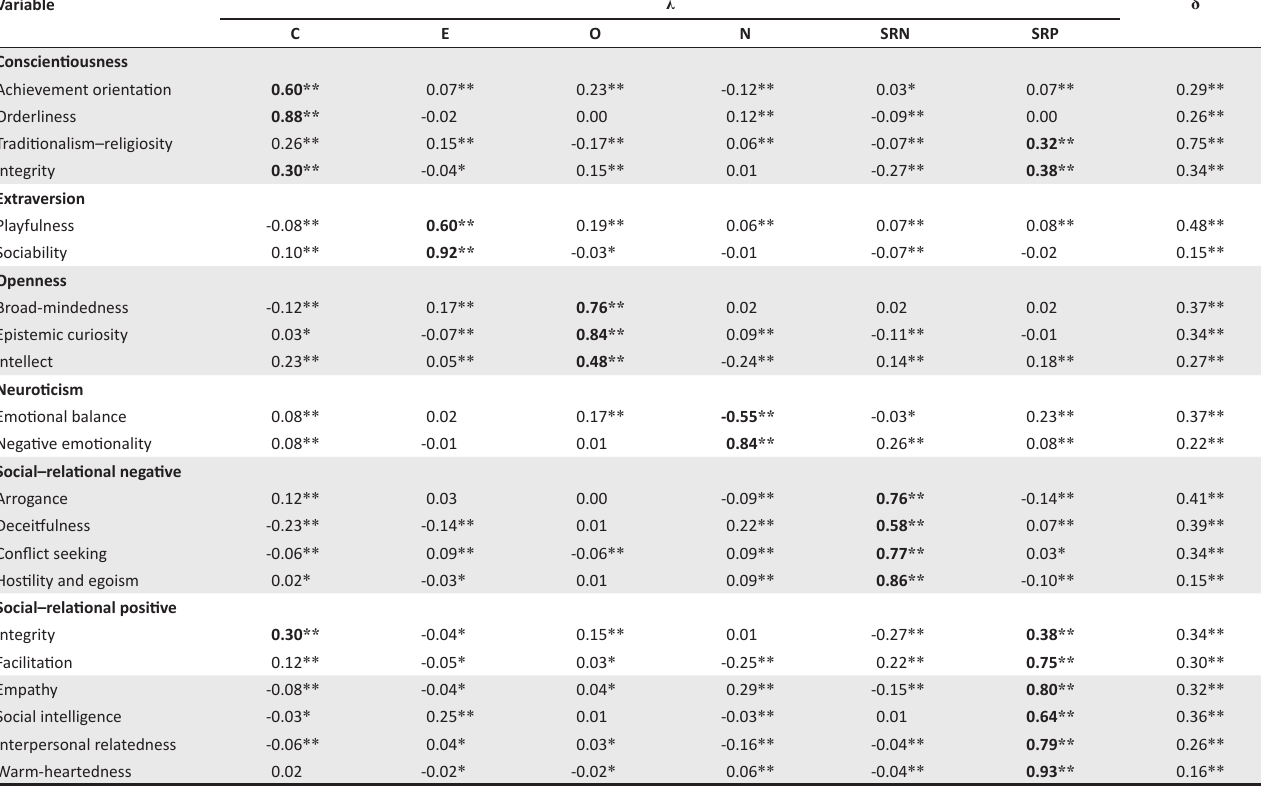
TABLE 4: Parameter estimates of the South African Personality Inventory based on the exploratory structural equation modelling analysis. Variable λ